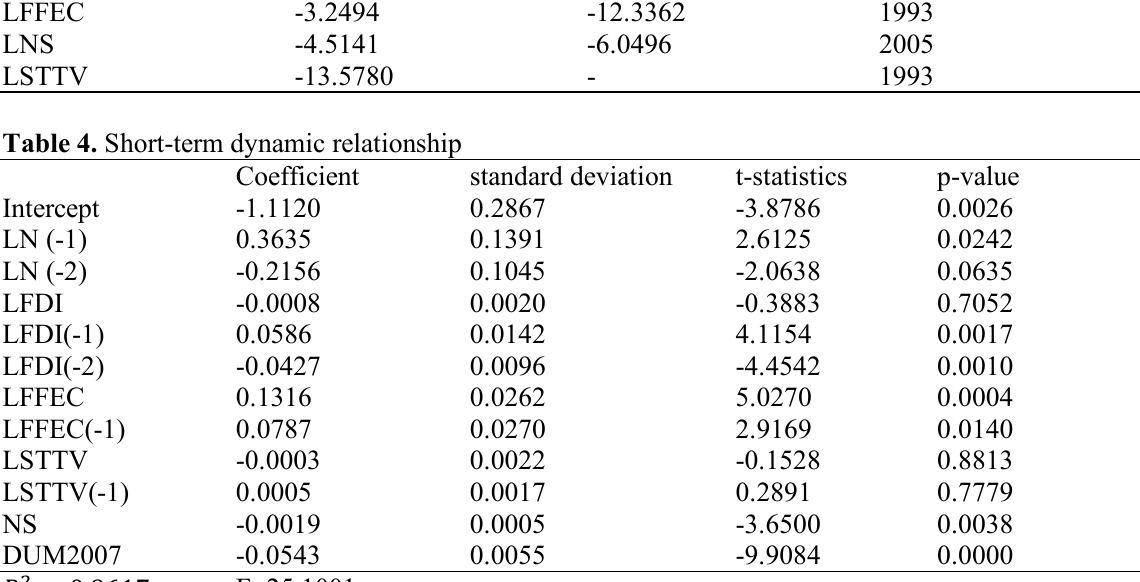
Table 3. Zivot-Andrew structural break unit root test.